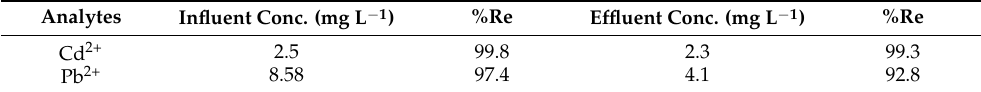
Figure 11. Pseudo-second-order equations for Cd 2+ and Pb 2+ using BPAC@Al 2 O 3 @chitosan. Table 4. Application of BPAC@Al 2 O 3 @chitosan composite material on the removal of Cd 2+ and Pb 2+ from real water samples.